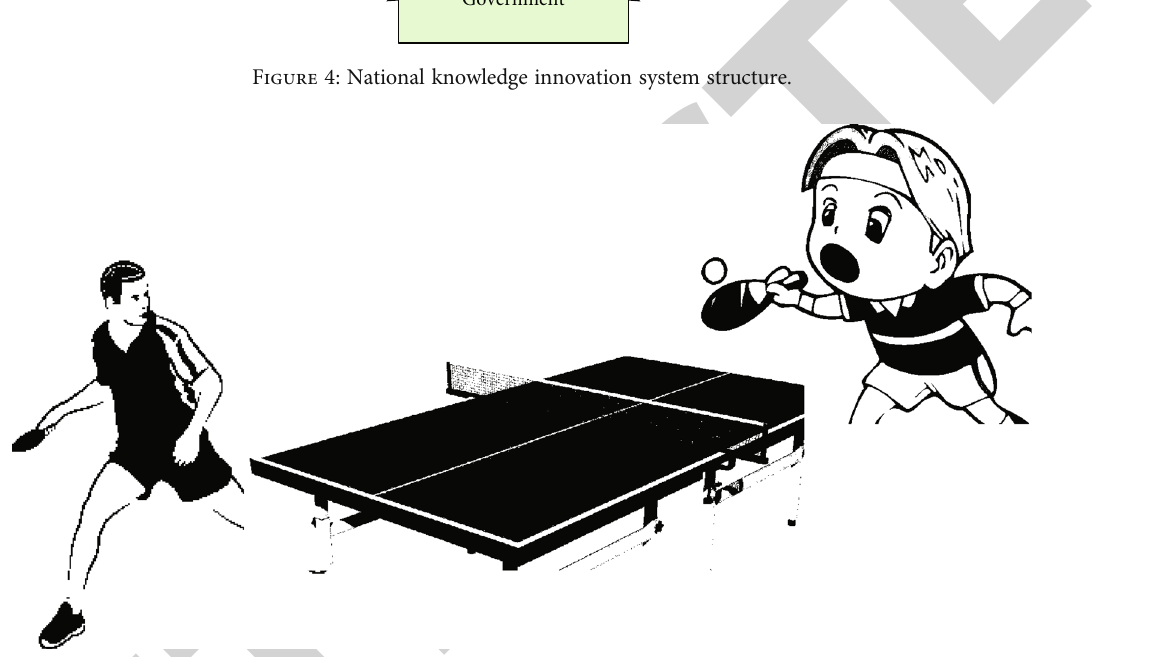
Figure 5: Coaches instruct young people to practice table